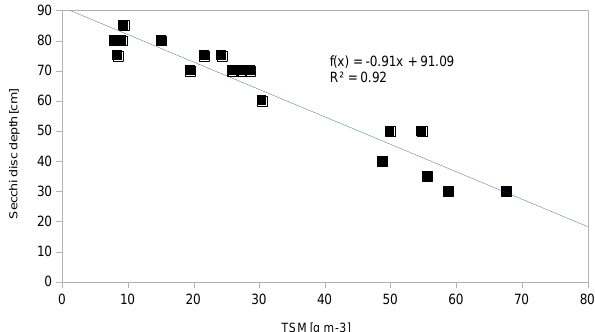
Fig. 10. Relationship between TSM dry weight and the Secchi disc depth for all Lena stations.